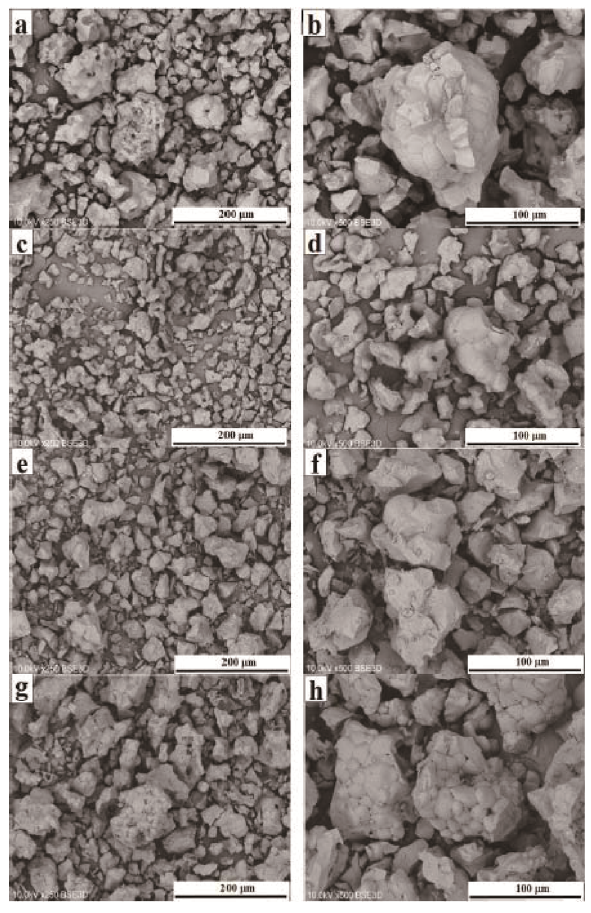
Fig. 5 SEM micrographs of PbMoO 4 (a, b) and Pb 1–3 x (cid:0) x Gd 2 x (MoO 4 ) 1–3 x (WO 4 ) 3 x materials obtained by combustion route for x = 0.0455 (c, d), x = 0.0839 (e, f), x = 0.1430 (g,